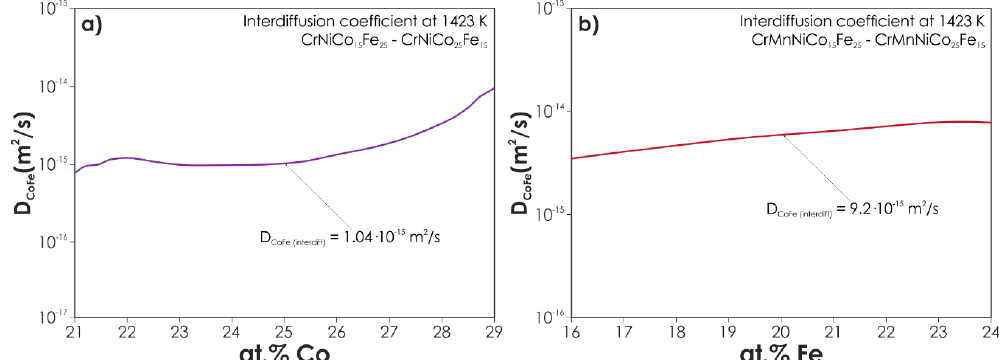
Figure 22. Concentration-dependent interdi ff usion coe ffi cients in ( a ) Co-Fe quaternary and ( b ) Co-Fe quinary di ff usion couple (after [42]). Reprinted from Scripta Materialia 157 (2018), Experimental assessment of the thermodynamic factor for di ff usion in CoCrFeNi and CoCrFeMnNi high entropy alloys, 81–85, Copyright 2018, with permission from Elsevier.